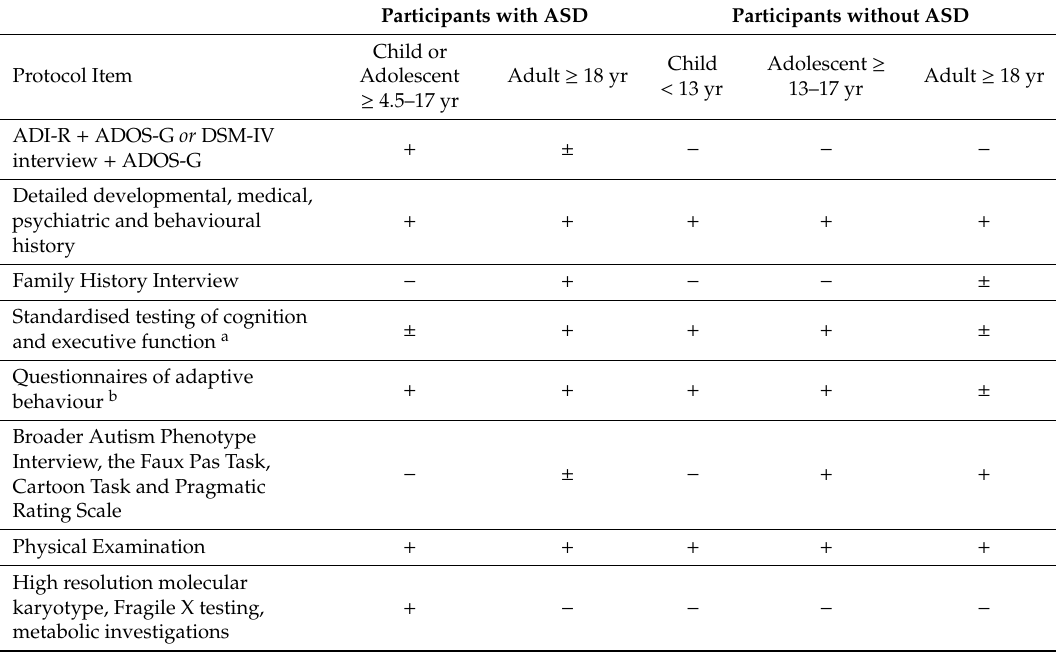
Table 5. Protocol for diagnosing ASD and phenotyping the Broader Autism Phenotype (BAP) in large multiplex